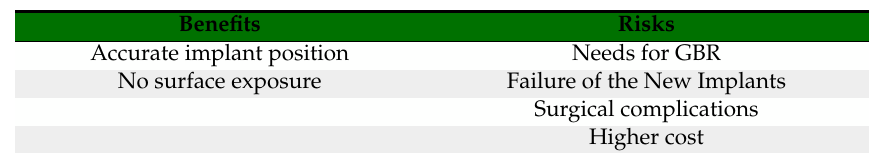
Table 2. Implant